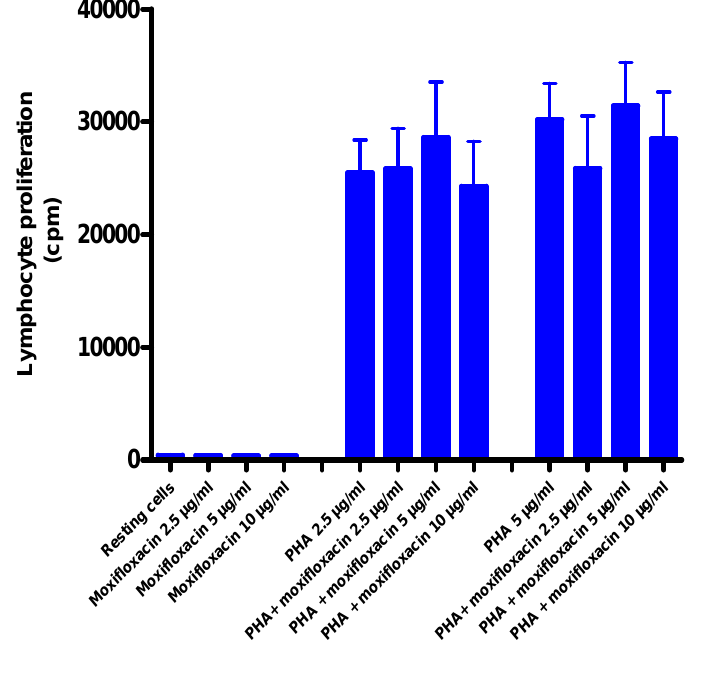
Figure 2. Effects of moxifloxacin on proliferation of PHA-activated